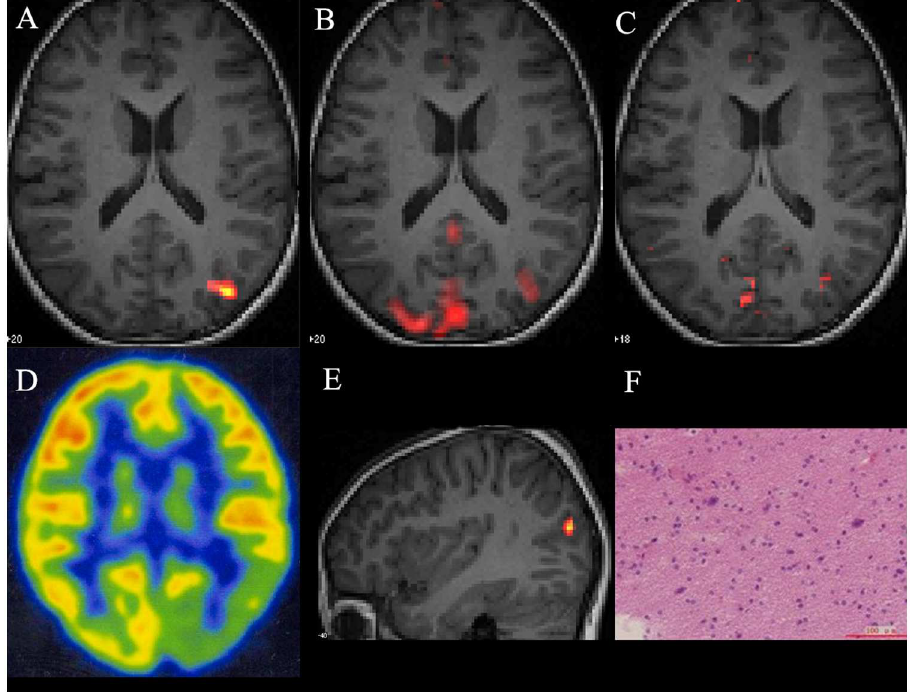
Fig 1. Left parieto-occipital lobe dysplasia in a MRI negative 9-year-old patient. (A) Axial and (E) sagittal fALFF, (B) axial ALFF, and (C) ReHo reveal abnormal activationin the left parieto-occipital lobe. (D) The corresponding 18 F-FDG PET/CT image shows low FDG uptake in the left frontoparietal region. (F) Pathological confirmation of left parieto-occipital lobe focal cortical